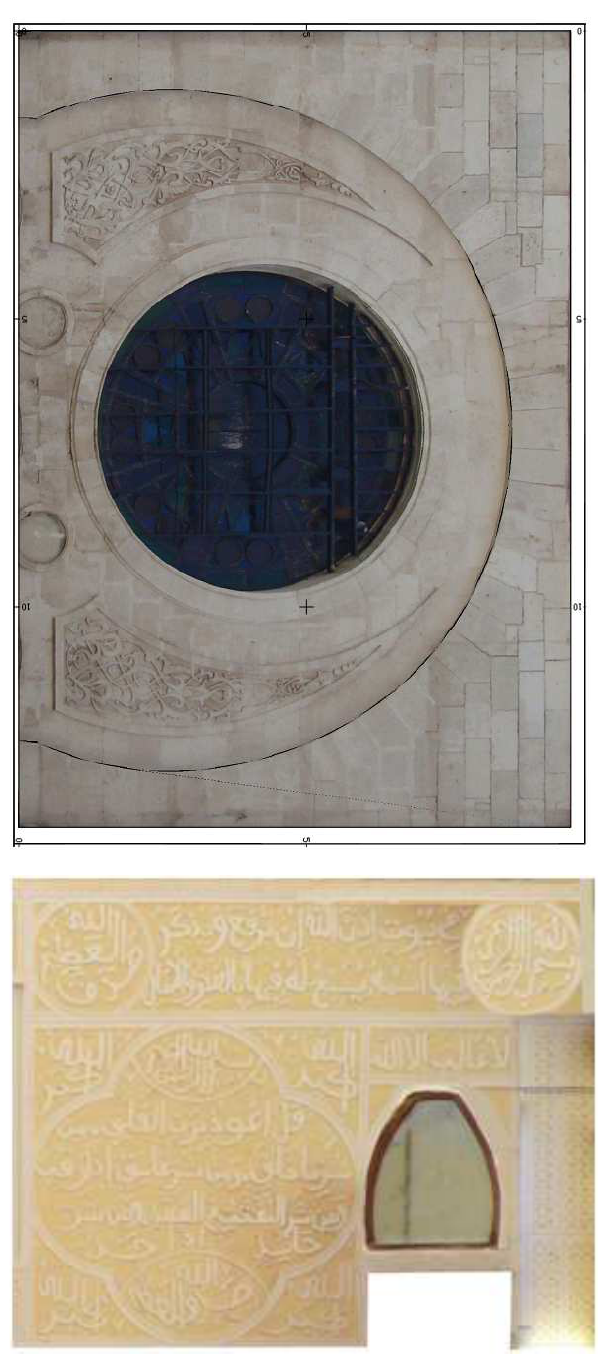
Figure 14. Example of the extracted